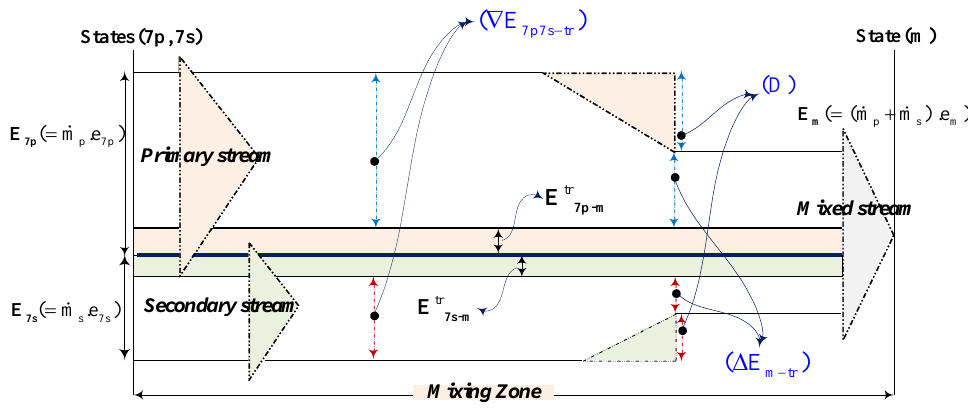
Figure 5. Diagram of Grassman illustrating transiting exergy in the mixing zone .